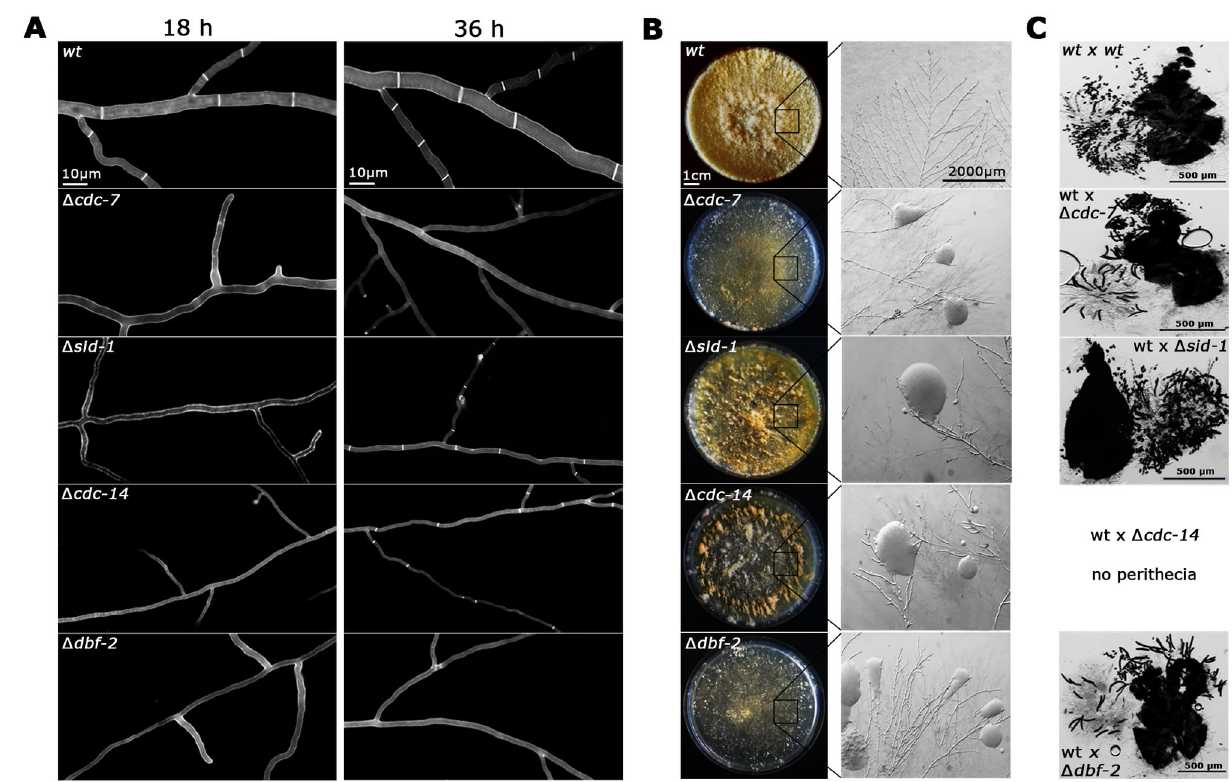
Figure 1. N. crassa SIN components are required for septum formation but display distinct mutant characteristics. ( A ) Deletion strains defective in the indicated SIN components generate thin and aseptate hypha in young colonies (18 h time point). In older colonies, the septation defects were suppressed in ∆ sid-1 and ∆ cdc-14 strains (36 h time point). Cell wall and septa were labeled with Calcofluor White. ( B ) SIN mutants showed cytoplasmic leakage (magnified inserts), but, due to the fast ability to septate, ∆ sid-1 and ∆ cdc-14 generated abundant aerial mycelium and asexual spores (conidia; plate morphology). ( C ) SIN mutants displayed distinct abnormalities during sexual development. wt x ∆ crosses with ∆ cdc-7 (het) and ∆ dbf-2 (het) resulted in the frequent formation of large, banana-shaped ascospores. In contrast, wt x ∆ sid-1 (het) progeny morphology was normal, while crosses of wt x ∆ cdc-14 (het) produced no mature perithecia